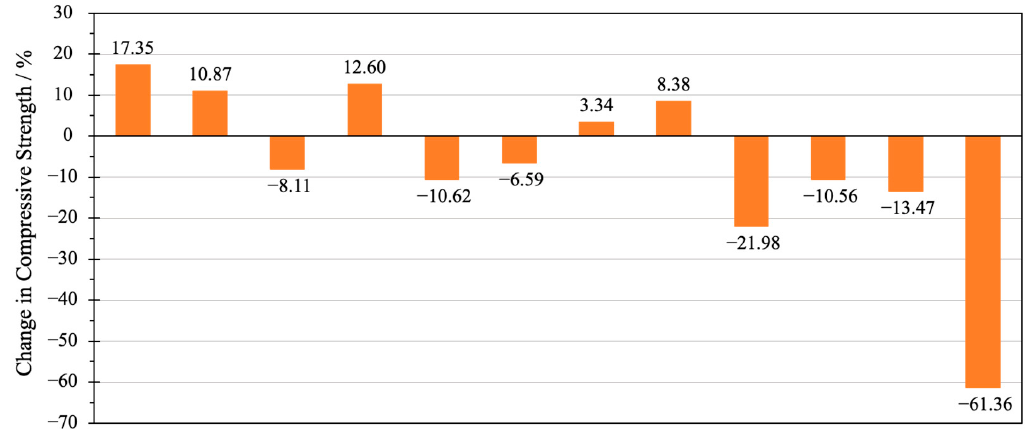
Figure 7. Changes in compressive strength of LWCM.